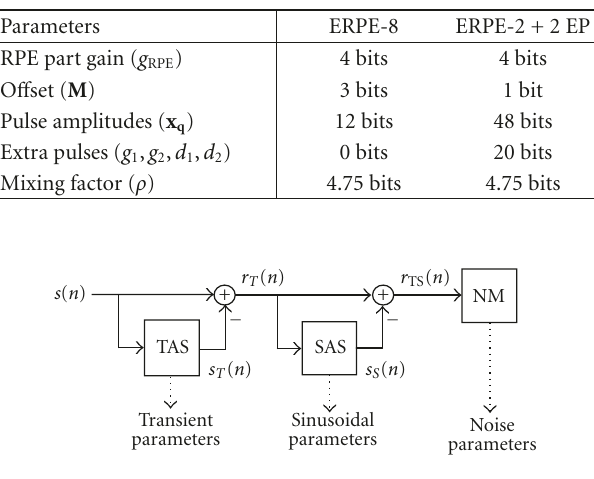
Figure 7: MPEG-4 SSC